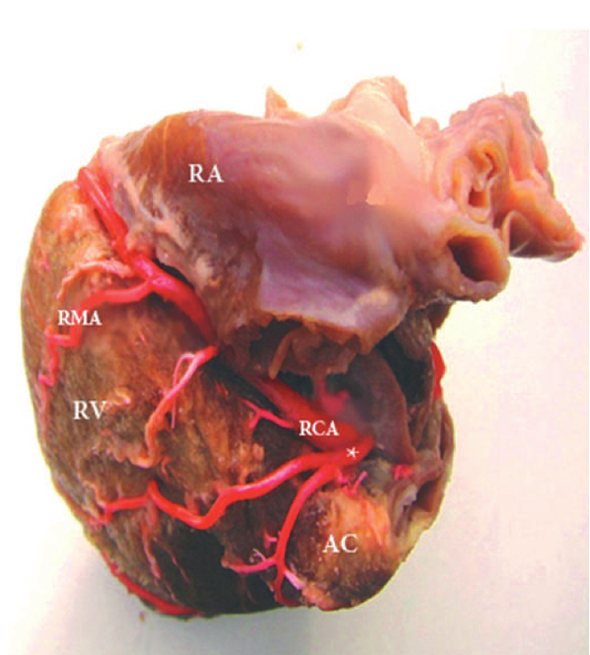
Fig. 2 - Antero-superior heart view. Conus arteriosus’ artery originated from aorta (third coronary) (*). RCA: Right coronary artery. AC: Arteriosus conus. RMA: Right marginal artery. RV: Right ventricule. RA: Right atrium